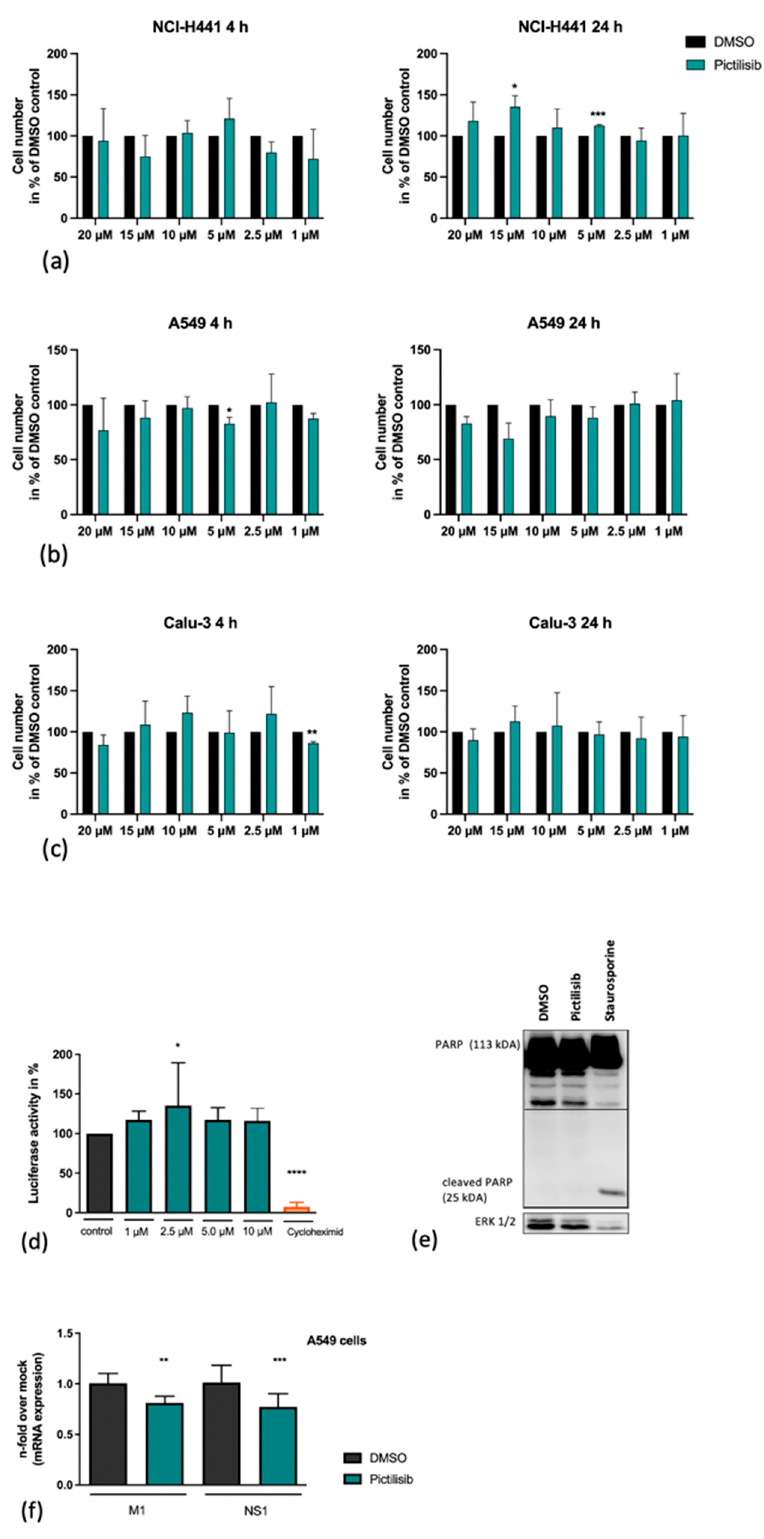
Figure 3. Pictilisib treatment does not affect cell viability. NCl-H441 ( a ), A549 cells ( b ) and Calu-3 cells ( c ) were treated with increasing amounts of Pictilisib (1–20 µ M) or DMSO in 500 µ L of medium with 10% FCS. After the indicated times cells were washed with PBS and detatched with 150 µ L/well Trypsin/EDTA. Subsequently, the procedure was stopped by adding 350 µ L/well medium with 10% FCS. 20 µ L of suspension was supplemented with 20 µ L 0.1% Trypan Blue and used for counting. ( d ) A549 cell were transfected with a constitutive active CMV promoter luciferase plasmid.